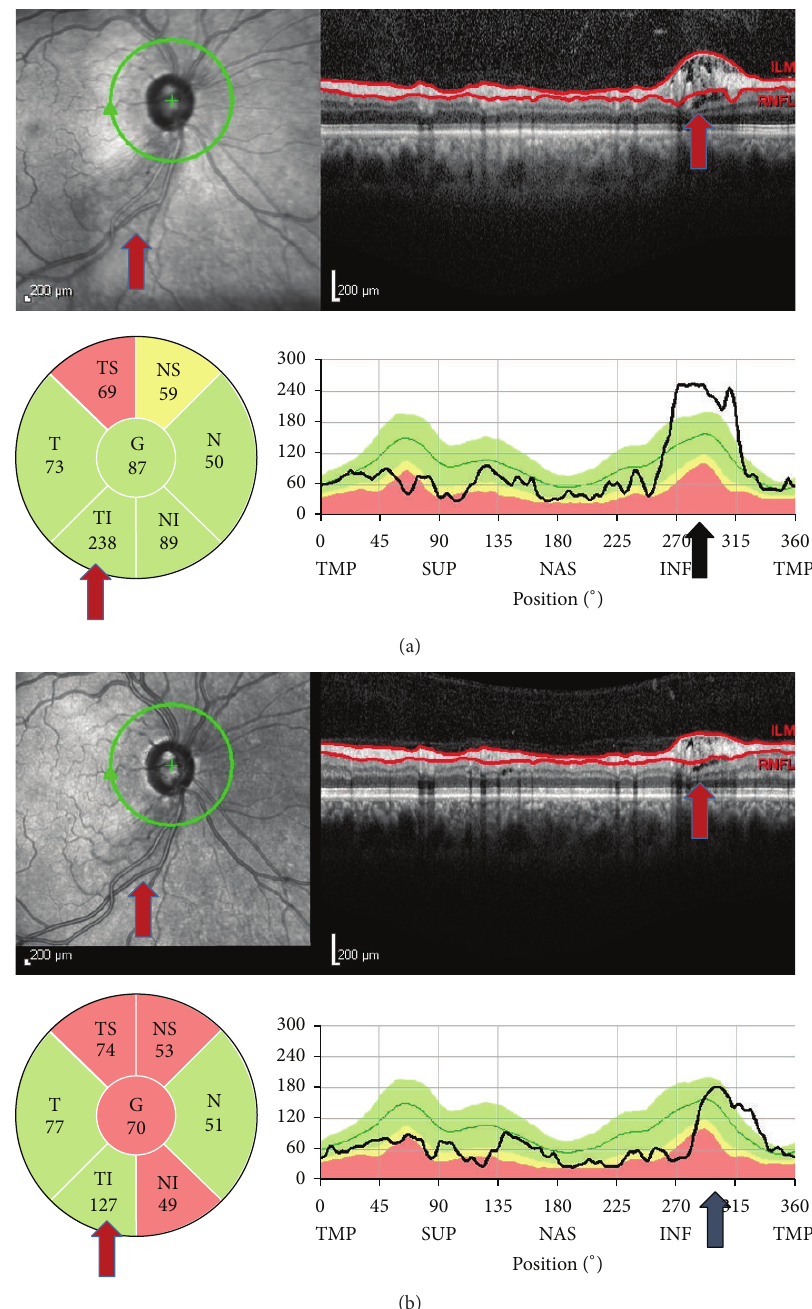
Figure 4: SD-OCT findings in a case of juvenile glaucoma. (a) The retinoschisis observed in the B-scan image (red arrows). (b) The extension of retinoschisis was smaller 3 months later (red arrows). According to the sector thickness map, inferotemporal RNFL was decreased from 238 𝜇 m to 127 𝜇 m. The remarkable decrease in the RNFL thickness in the inferotemporal area is also seen in the TSNIT graphs (black